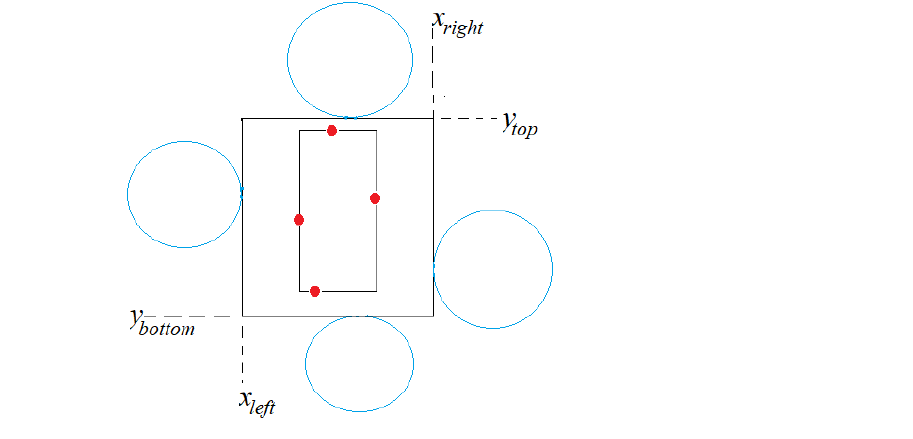
Figure 11. A circle bounding a rectangle at an edge makes that edge fixed in terms of either X or Y coordinate.